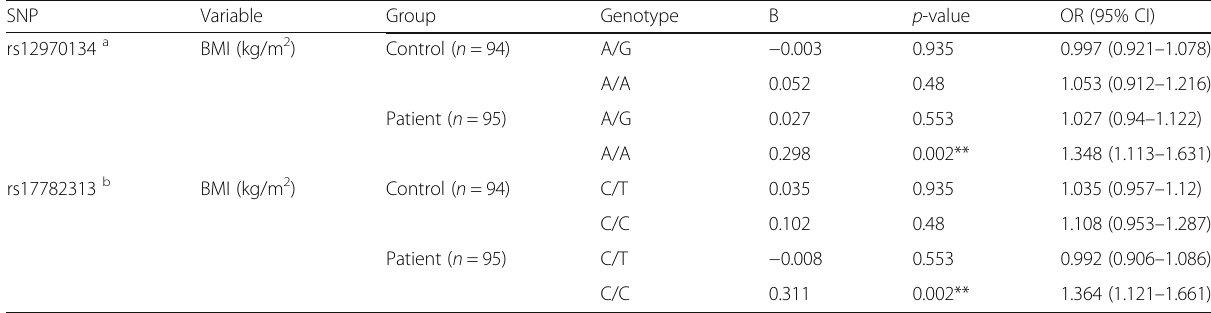
Table 4 Impact of MC4R variants rs12970134 and rs17782313 on PCOS using a multinomial logistic regression test